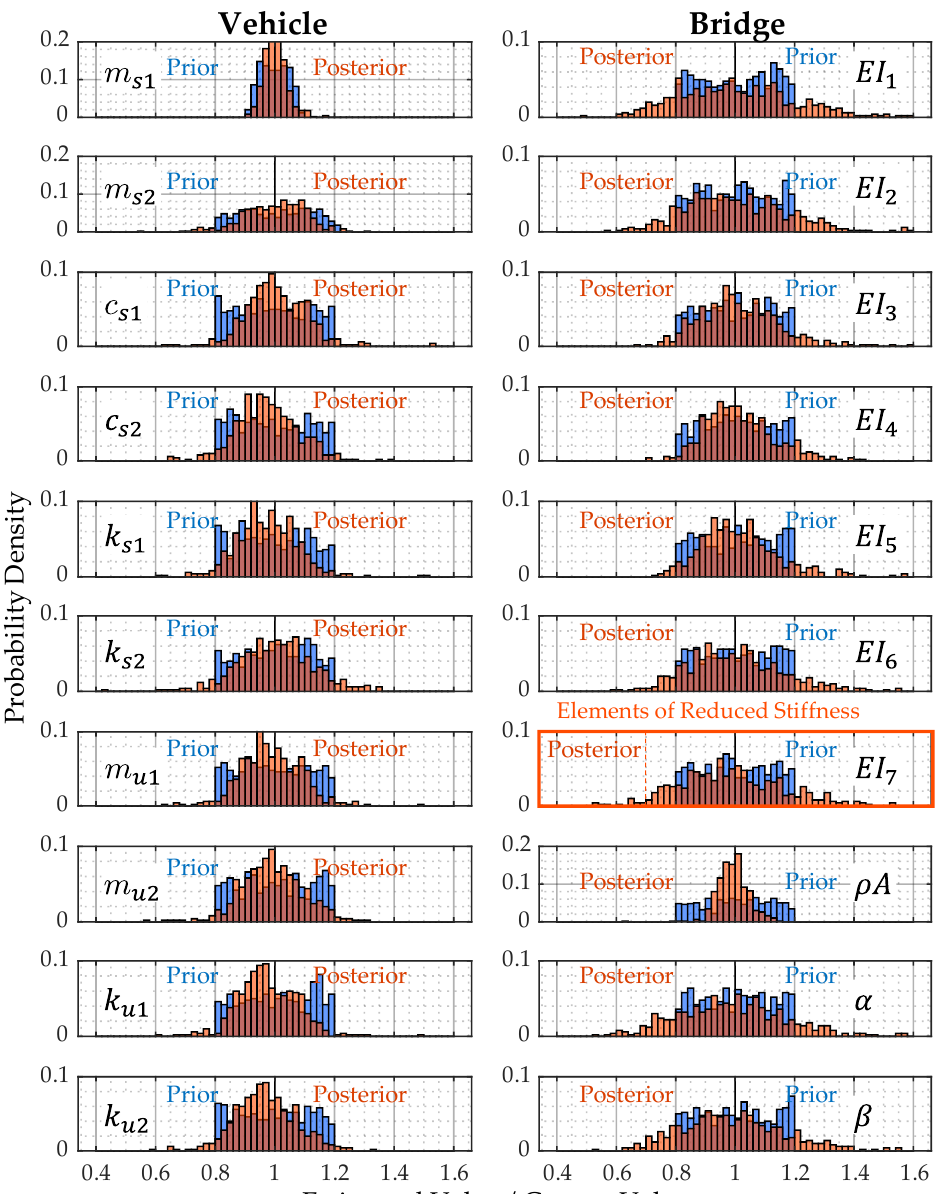
Figure A13. The application results of the PRE method in the case of Scenario 11 (stiffness decrease section: 6𝐿/7 ~ 𝐿 , decrease rate: 30%).